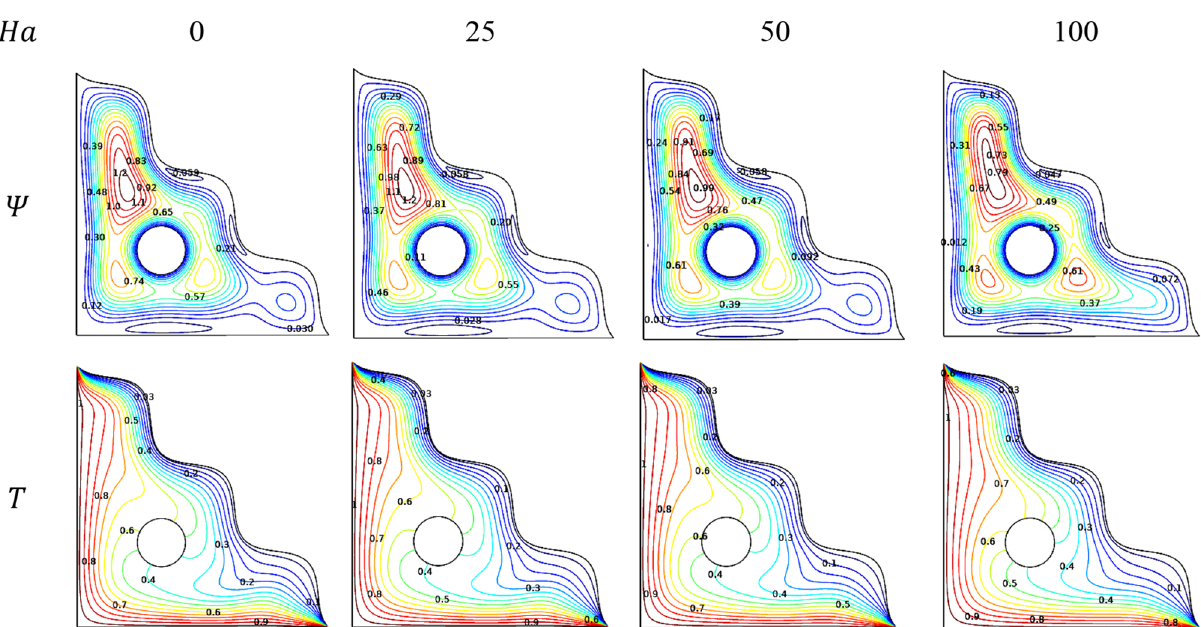
Figure 9. Variations of the streamlines ( (cid:31) ) and isotherms ( T ) with various Ha , Ra = 10 6 , Da = 0.01 , φ = 0.02 , ω = 0 , N = 4 , r = 0.1 and ε = 0.2